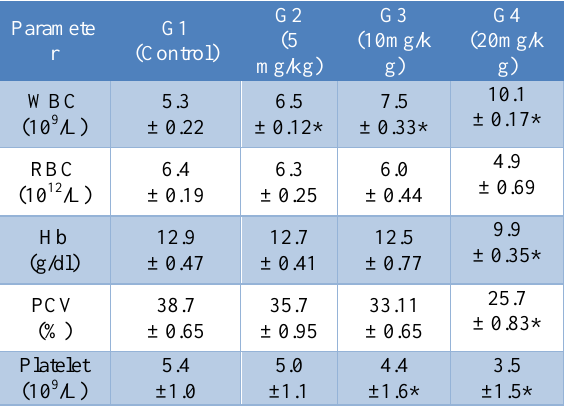
Table, 2: Mean values of hematological tests following administration of Azorubine on day 30.